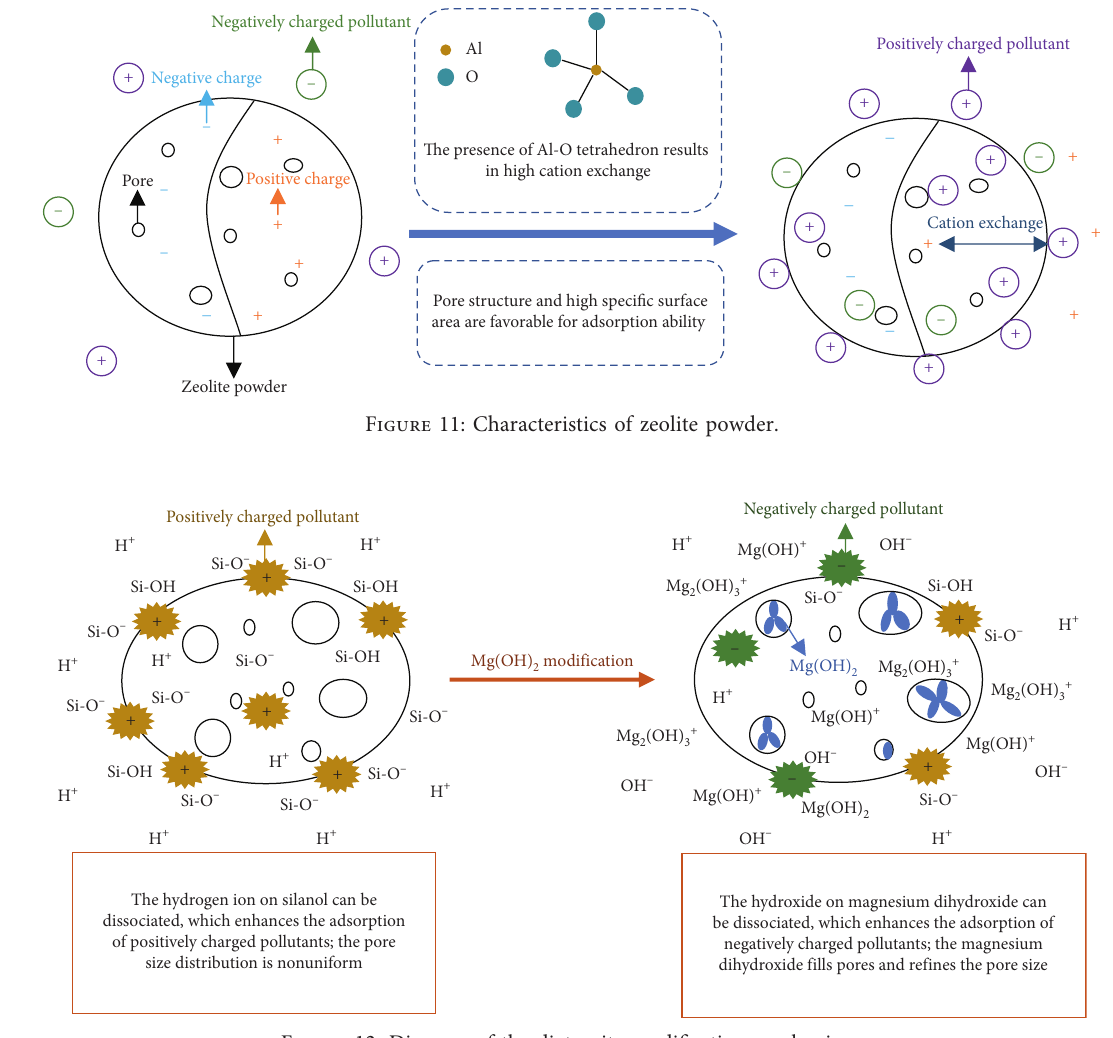
Figure 12: Diagram of the diatomite modification mechanism. Table 7: Evaluation indexes for gray correlation